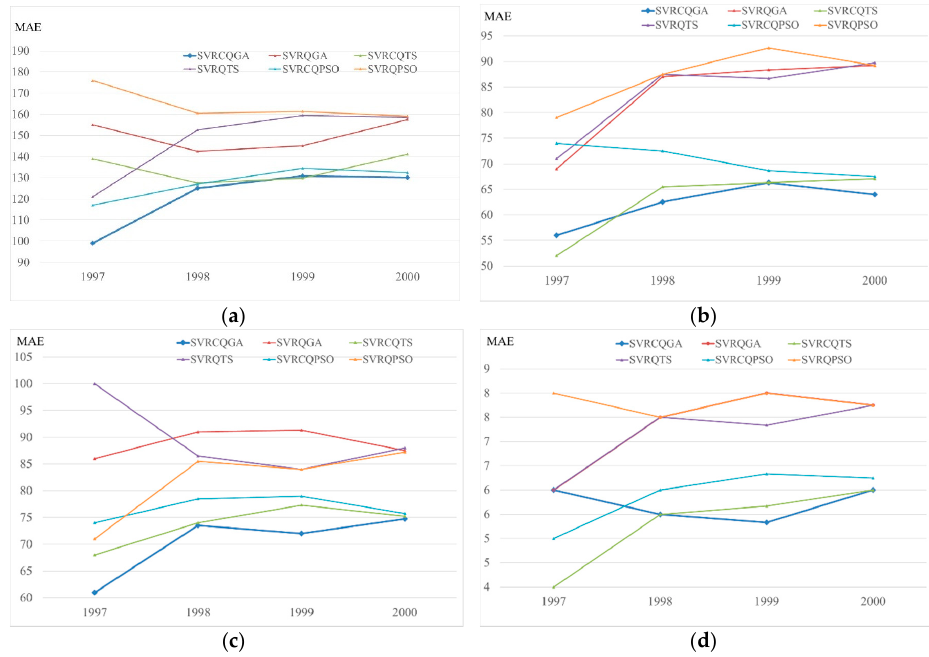
Figure 5. The cumulative differences of MAE for each competitive models in four regions (Example 1). ( a ) Northern region; ( b ) Central Region; ( c ) Southern region; ( d ) Eastern region.